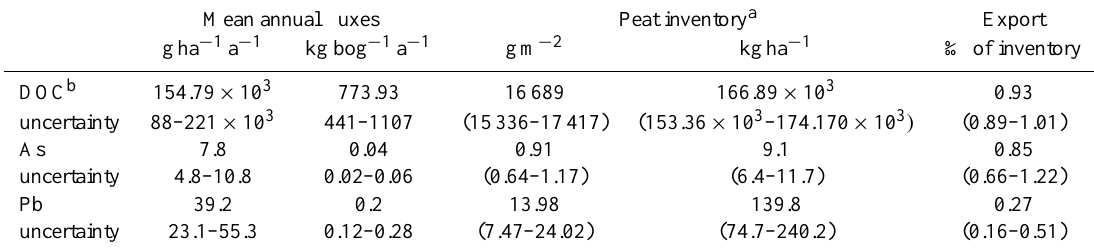
Table 2. Estimated mean DOC, As and Pb export in 2013 and element inventories in the upper 30cm of peat. Uncertainties were estimated by the standard deviation of flux calculations and element inventories calculated for each